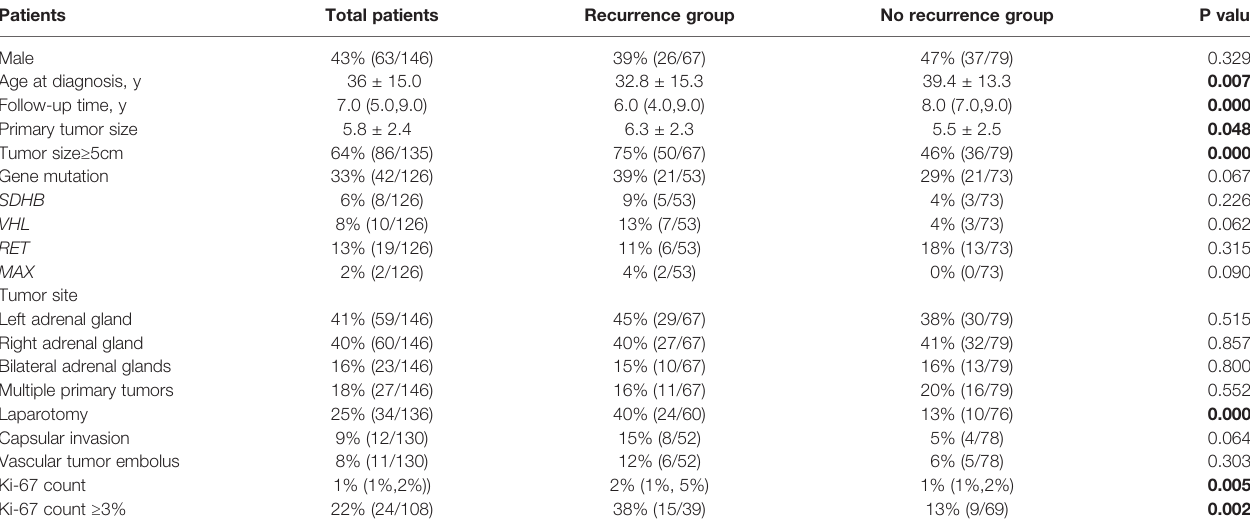
TABLE 3 | Differences in clinical characteristics between pheochromocytoma patients with and without recurrence. Patients